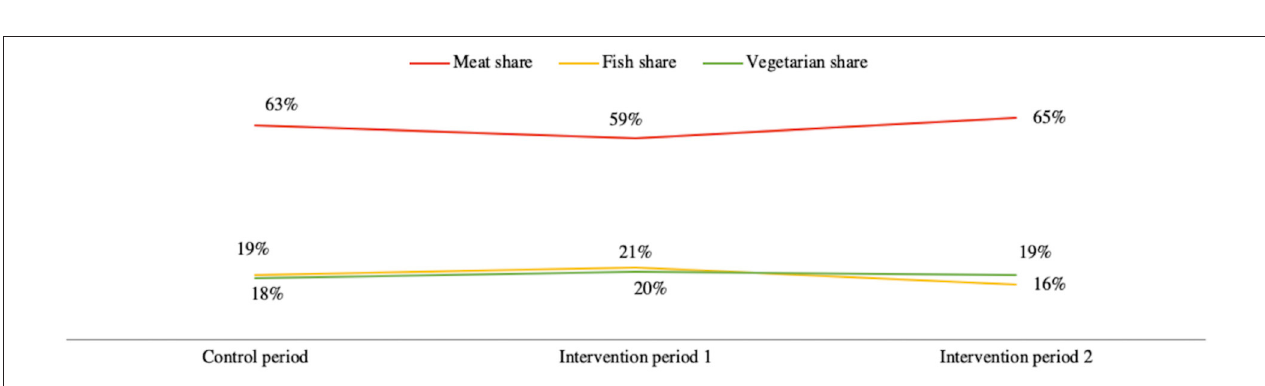
FIGURE 4 | Sales share of different dishes under single-green labels vs. no labeling.